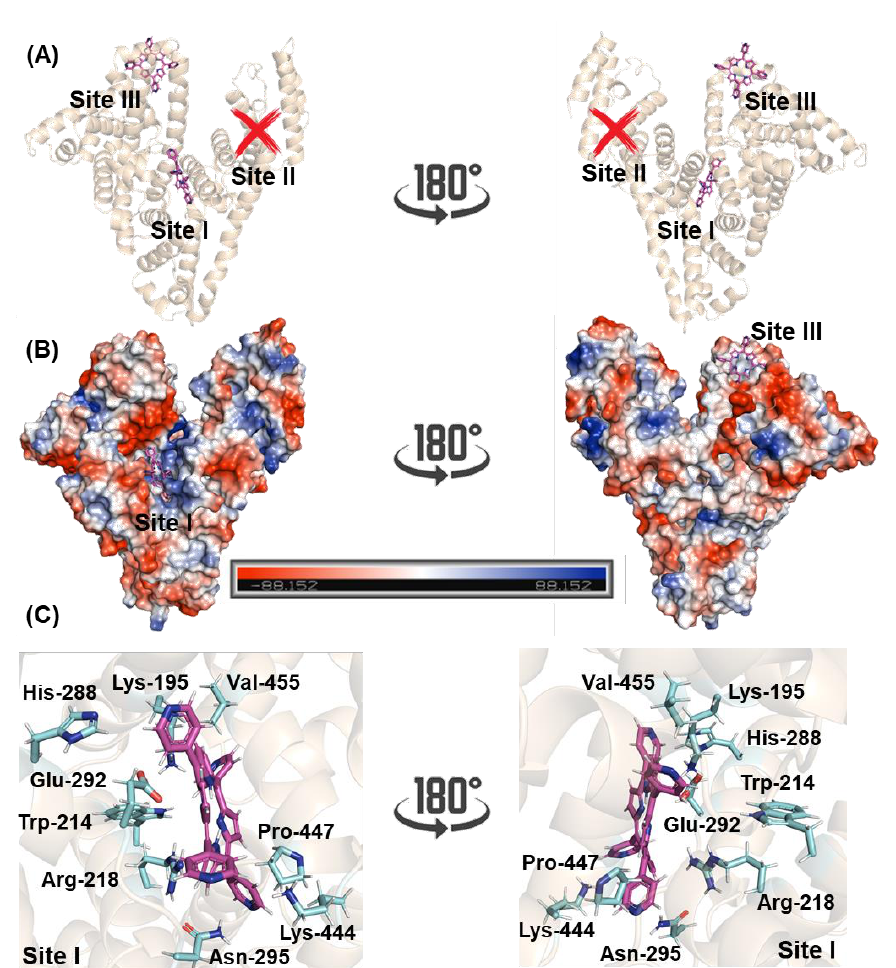
Figure 7. Superposition of molecular docking results for the interaction HSA:4-TPyP into subdomains IIA and IB (sites I and III, respectively) in terms of ( A ) cartoon representation and ( B ) electrostatic potential map for albumin (blue and red for positive and negative electrostatic density, respectively). ( C ) The main amino acid residues that interact with 4-TPyP into site I. Selected amino acid residues and 4-TPyP are represented as sticks in cyan and pink, respectively. Elements’ color: hydrogen, nitrogen, and oxygen in white, dark blue, and red, respectively. Table 3. The main amino acid residues and interactive forces for HSA:4-TPyP in the site I. Amino Acid